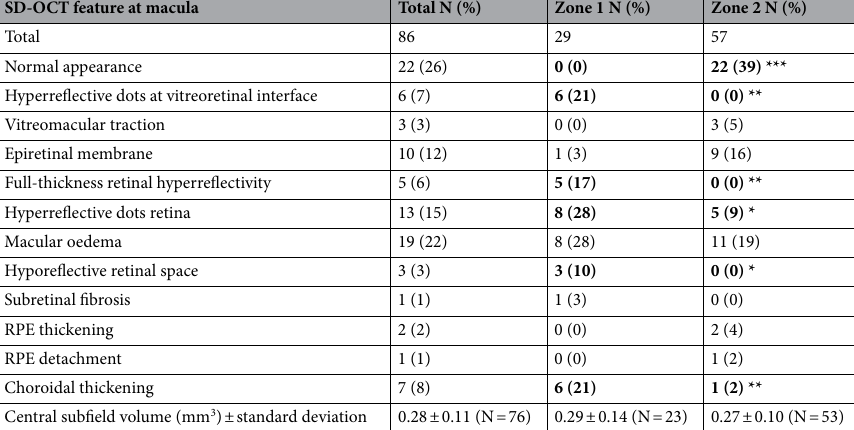
Table 3. Macular findings on SD-OCT in active TRC at presentation for 86 eyes (86 patients). Comparison was made between TRC lesions located in zones 1 and 2. The p values were calculated using Fisher’s exact test or Student t-test (* p < 0.05, ** p < 0.01, *** p < 0.001). SD-OCT = spectral domain optical coherence tomography; TRC = toxoplasmic retinochoroiditis; RPE = retinal pigment